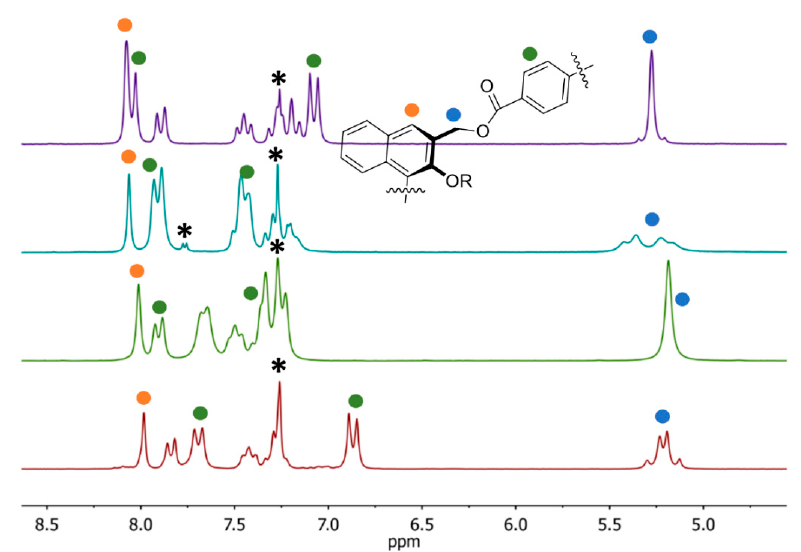
Figure 1. Aromatic and CH 2 benzylic ester region for the 1 H NMR spectra (CDCl 3 , 200 MHz, 25 °C) of macrocycles (from top to bottom) 5a , 5b , 6b , 6a . The asterisk marks impurities and residual solvent.